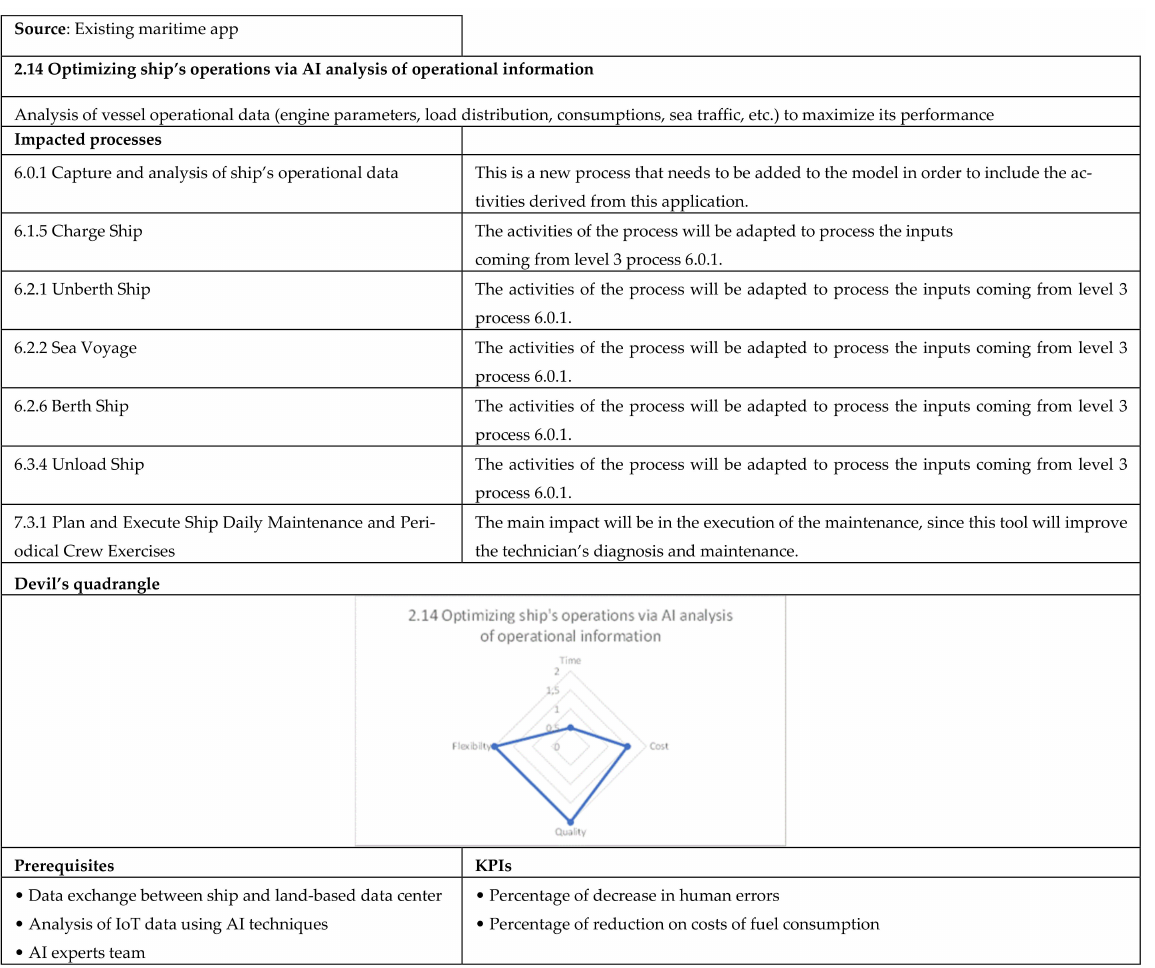
Figure A17. Analysis of ship structure images to anticipate issues data sheet.